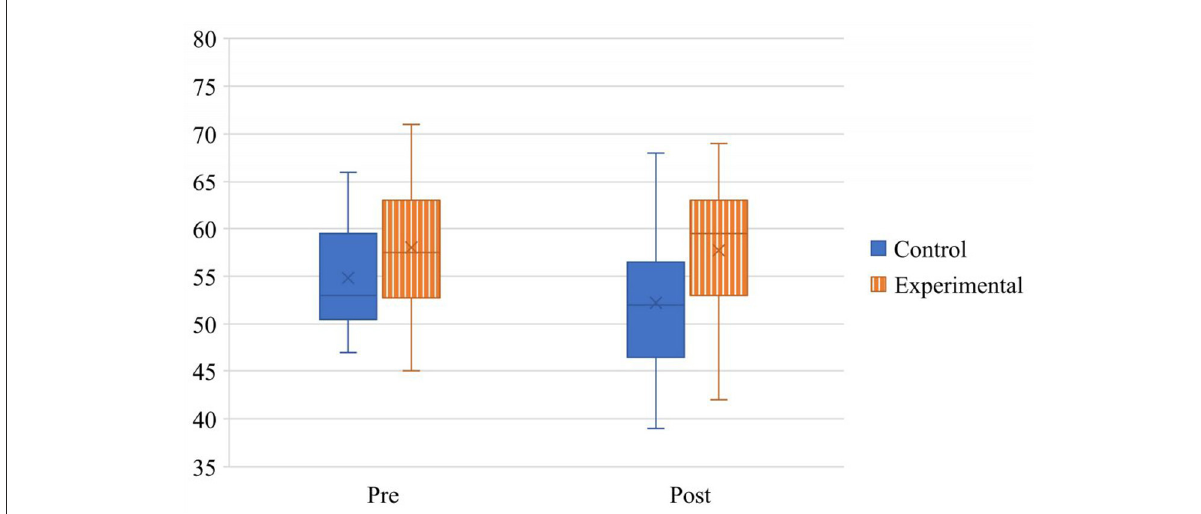
FIGURE1 Main effect of condition on teachers’ beliefs about the characteristics and behaviors of students identified as 2e.